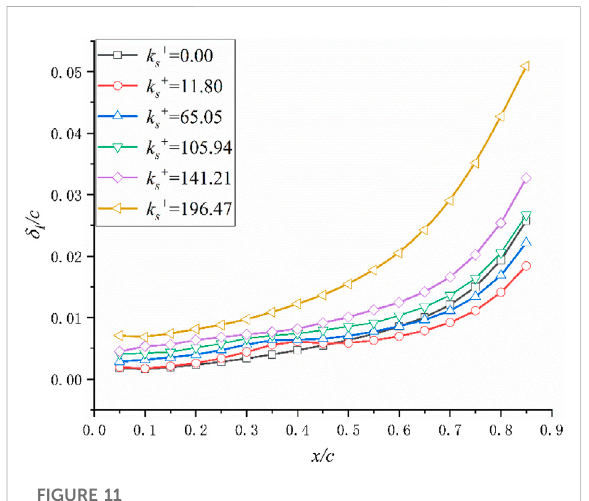
FIGURE 11 Displacement thickness ( δ 1 ) on the suction surface.